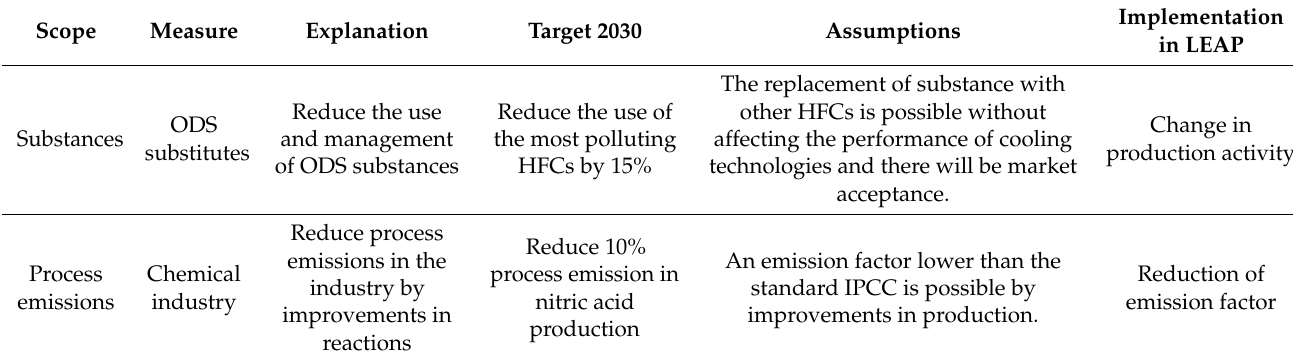
Table A4. Mitigation actions of IPPU included in the mitigation scenario.